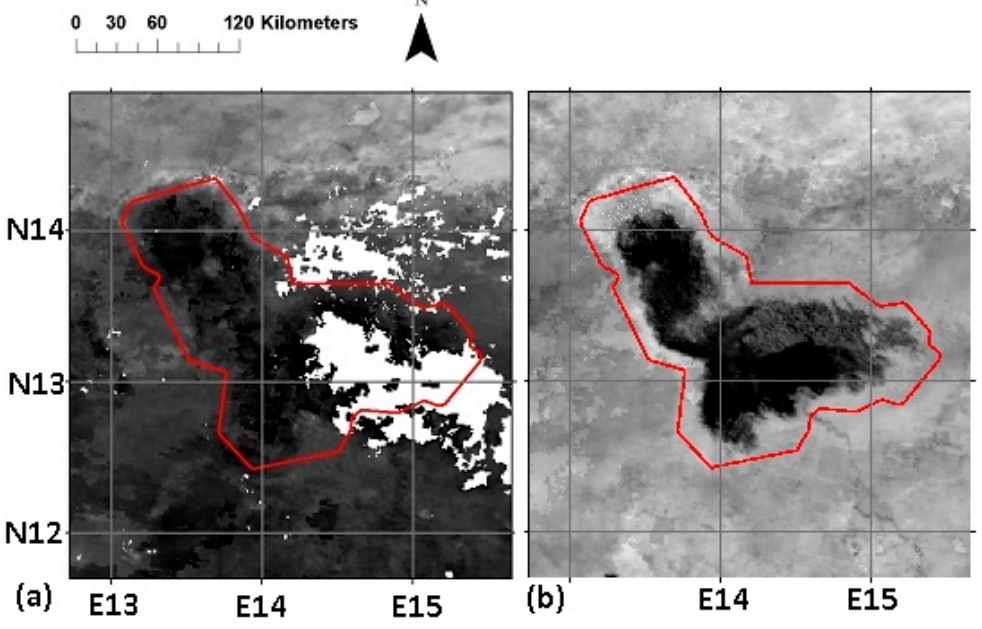
Figure 4. Example NASA MODIS Land Surface Temperature (LST) data during ( a ) wet season (12 August 2016) ( b ) dry season (15 April 2017) White areas in ( a ) are no data.